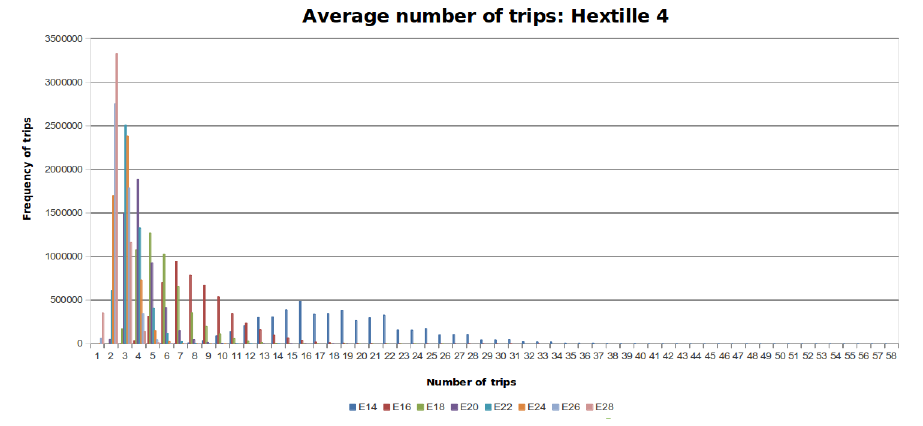
Figure 11. DFG G 4 with the variation of the required number of steps (cid:101) h for the 5,000,000 flights. The average number of trips for G 4 with (cid:101) h is 19 trips with a frequency close to 500,000 to explore the whole DFG. If the number of steps is incremented, the average number of flights